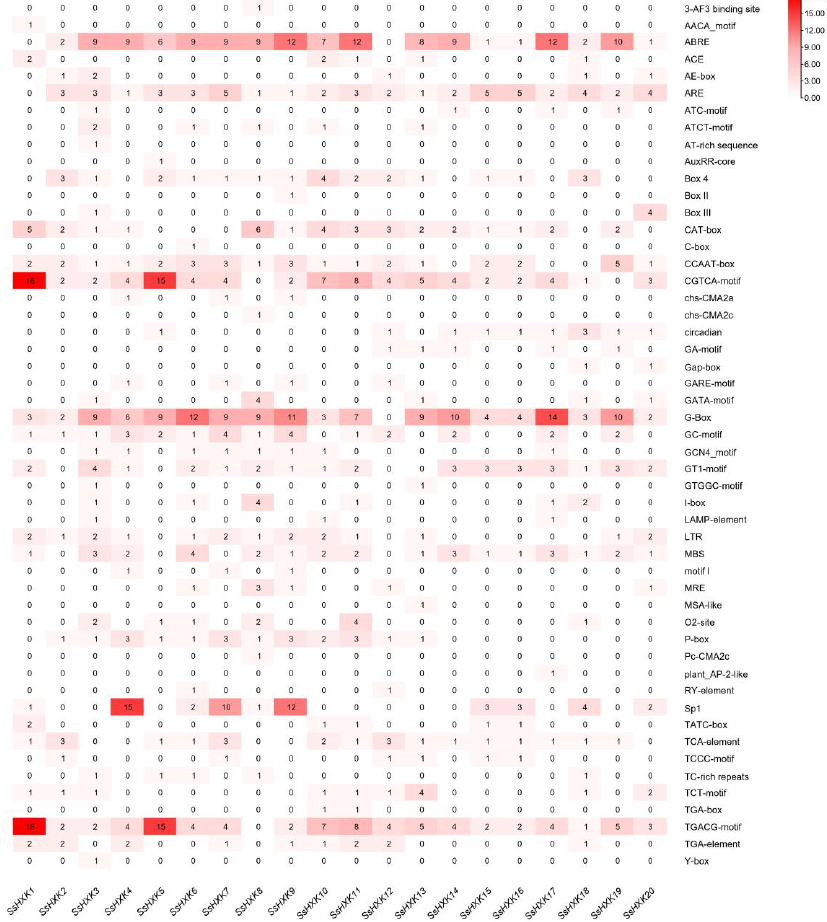
Figure 6. Types of cis-elements in the promoters of SsHXK genes . The rightmost column represent s the types of cis-elements in the promoters of SsHXK genes. The numbers in the box are the number of